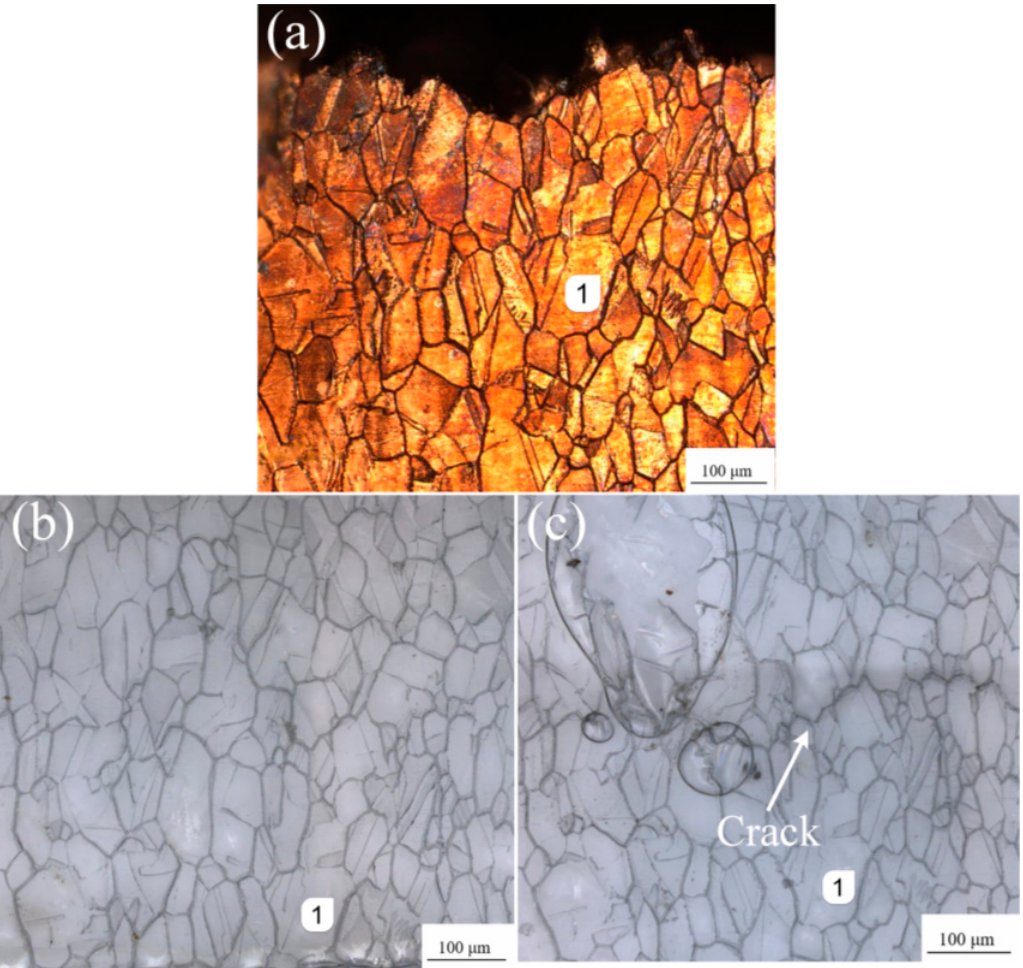
Figure 13. Side view of fracture and corresponding replica film (etched overload specimen): ( a ) the fracture side view of the etched surface specimen; ( b ) the photograph of the replica films before testing; ( c ) the photograph of the replica films near fracture.